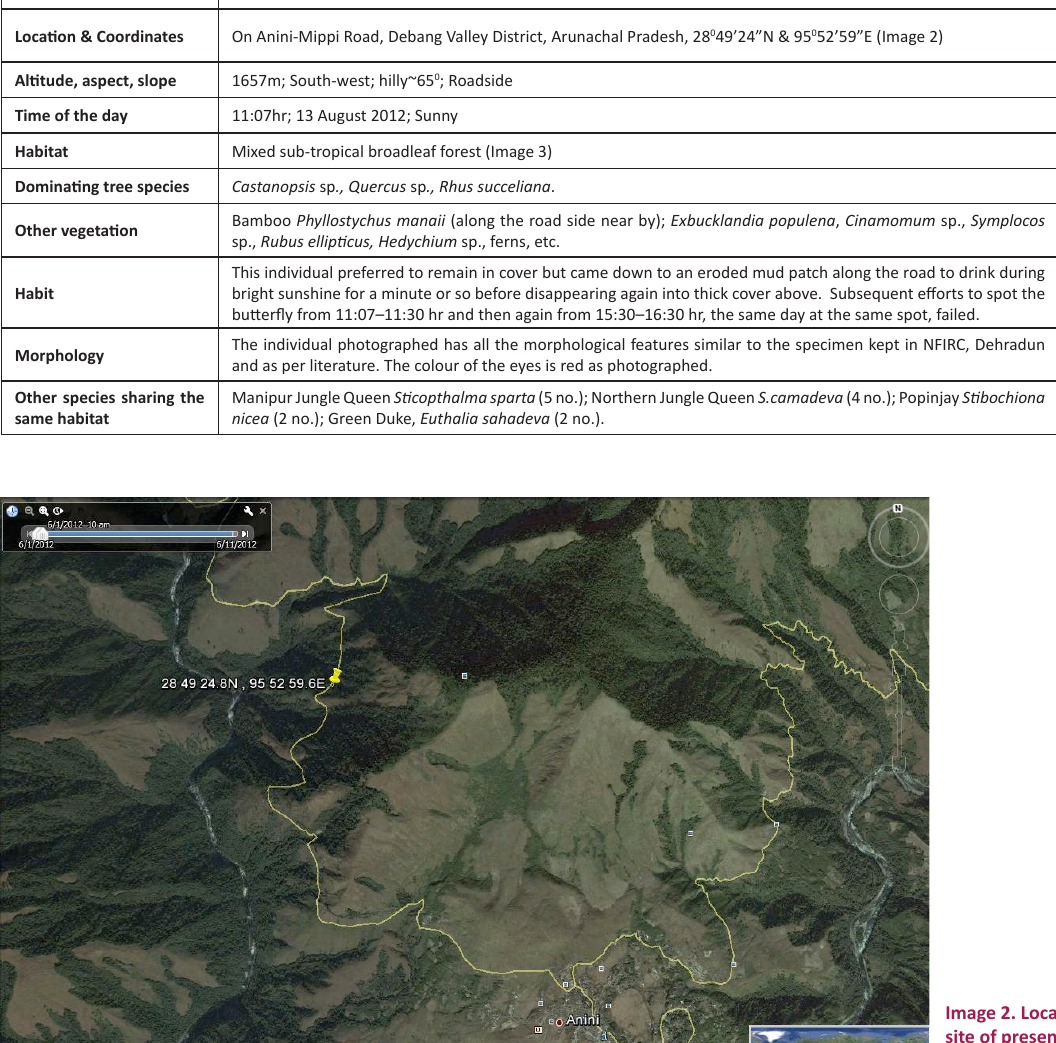
Image 2. Location of the site of present record of the Empress, Sasakia funebris near Anini, Upper Debang Valley District, Arunachal